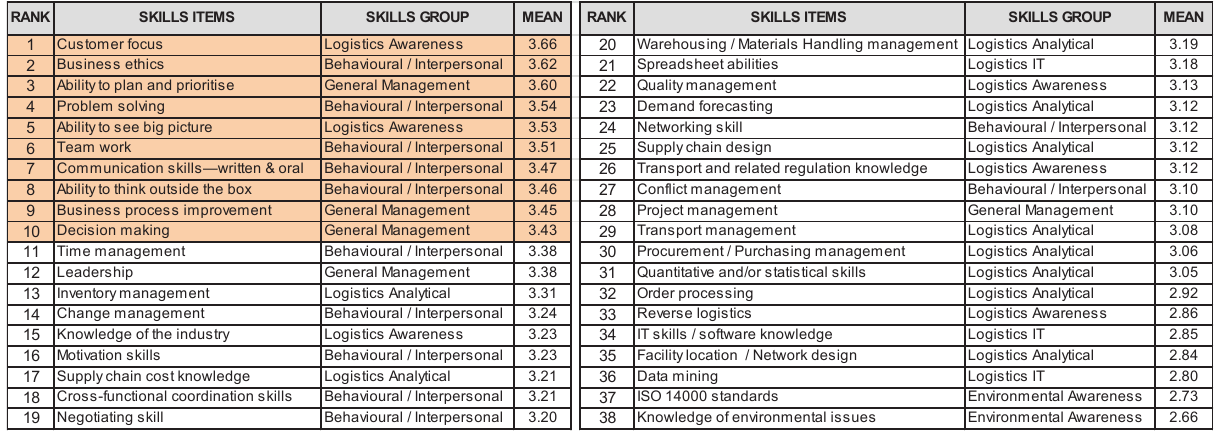
Table 4: Mean rating of proposed skills of logistics managers RANK SKILLS